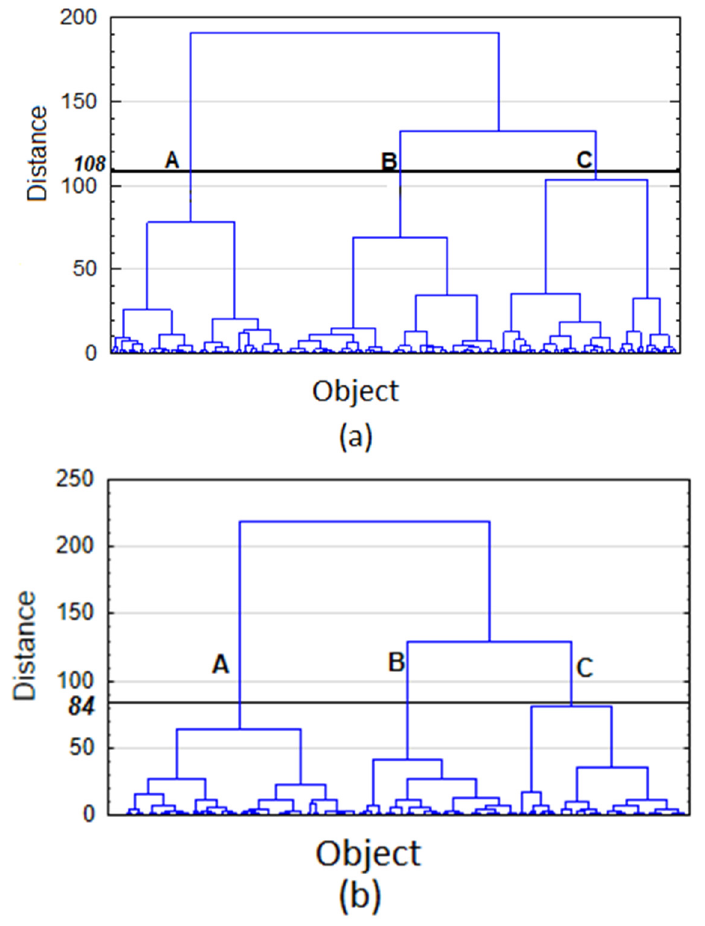
Figure 1. Hierarchical clustering results: ( a ) W-1 well; ( b ) W-2 well.